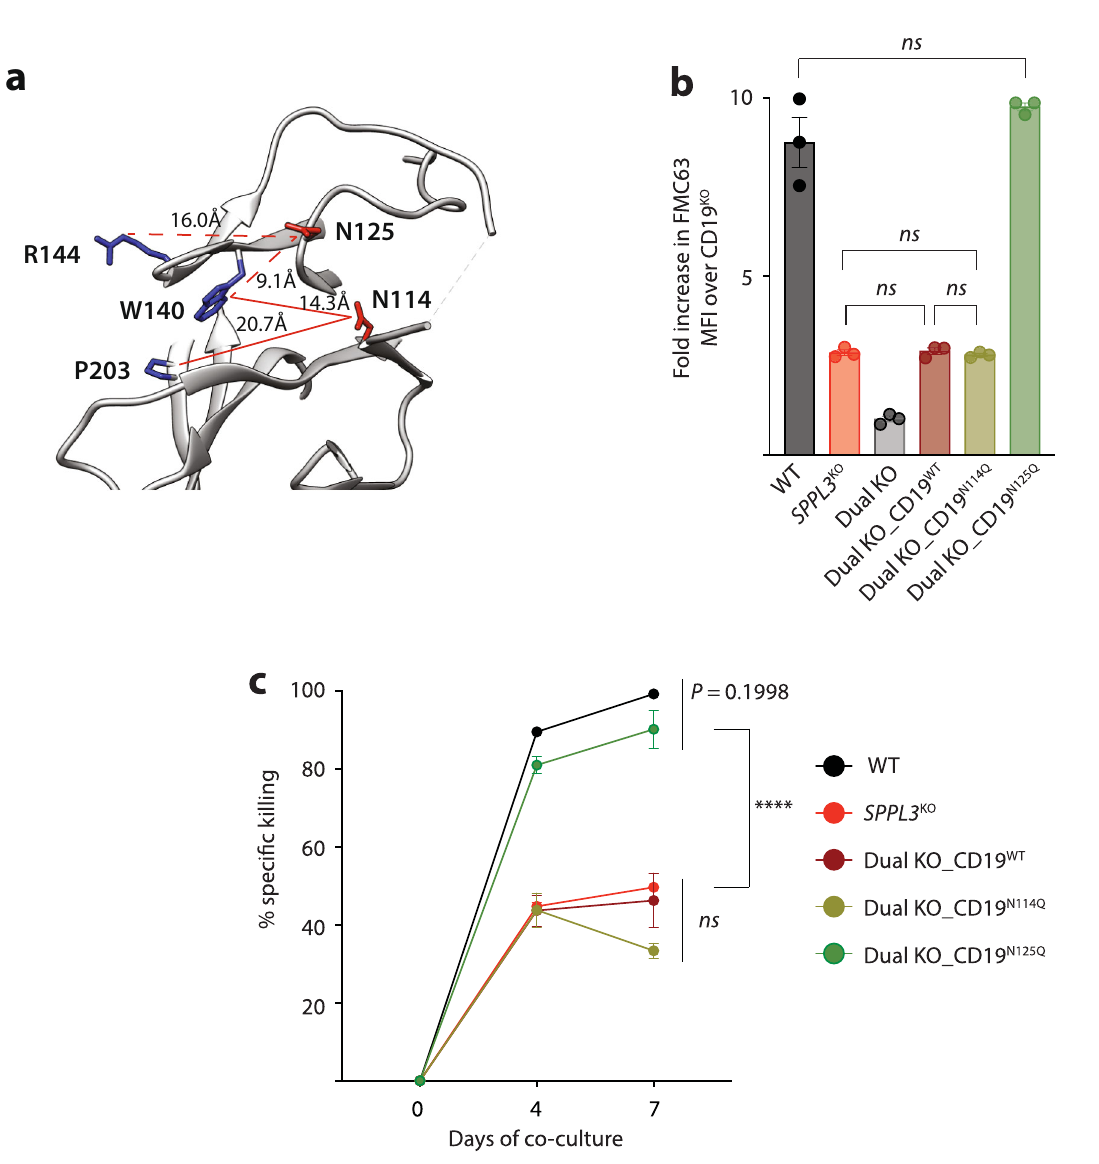
Fig. 4 Hyperglycosylation of asparagine 125 is responsible for impairing CART19 ef fi cacy. a Structural modeling of the FMC63 binding epitope on CD19. Residues in blue (R144, W140, and P203) are essential for antibody binding and proximal asparagine residues are in red (N125 and N114). b Median Fluorescence Intensity of CD19 as detected by FMC63-APC on the surface of WT, SPPL3 KO or SPPL3 KO CD19 KO (dual KO) Nalm6 cells engineered to express mutated CD19 molecules. Representative data from n = 2 fl ow cytometry experiments. c Survival of Nalm6 cells over time after combination with CART19 (E:T ratio 0.25:1). Representative data from n = 2 experiments with independent T cell donors. Error bars re fl ect mean ± standard error of the mean (s.e.m.). **** P < 0.0001 by two-way ANOVA with Bonferroni correction for multiple comparisons. Source Data are provided as a Source Data fi